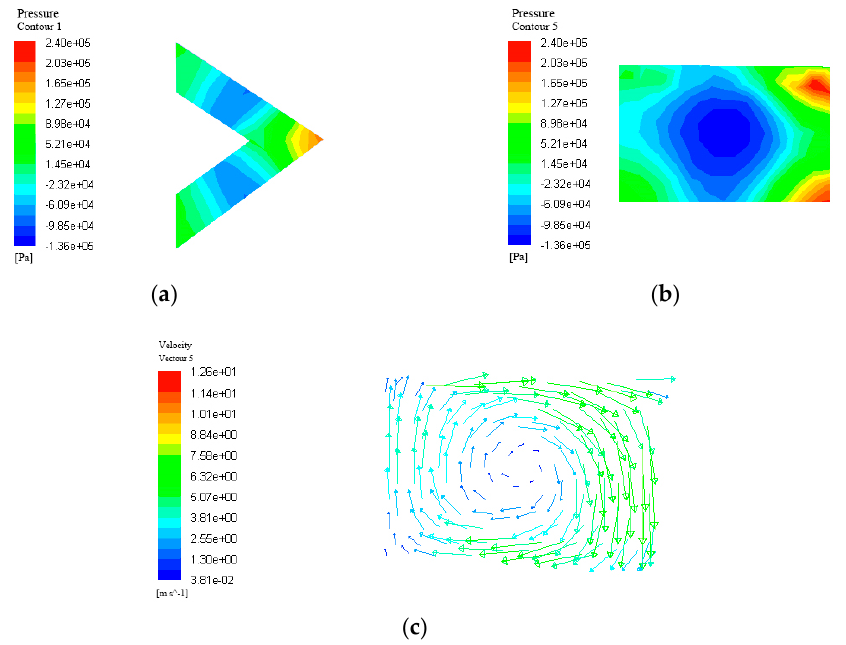
Figure 5. Cross-sectional and longitudinal section pressure distribution and flow velocity vector distribution of fluid in triangular groove micro-textures: ( a ) cross-sectional pressure distribution; ( b ) longitudinal section pressure distribution; ( c ) longitudinal section speed vector distribution.